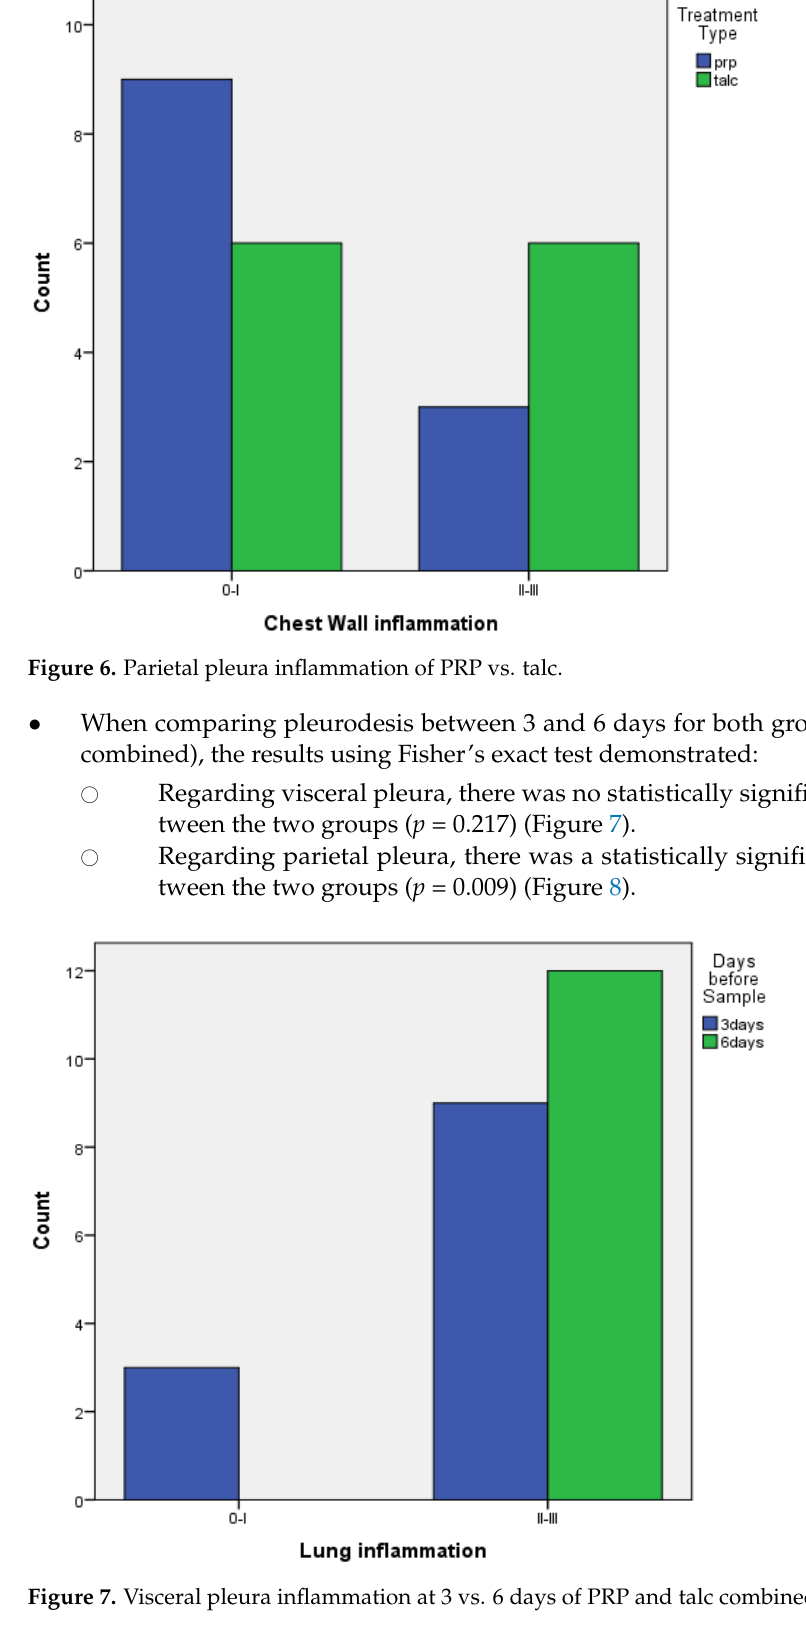
Figure 5. Visceral pleura inflammation of PRP vs. talc.